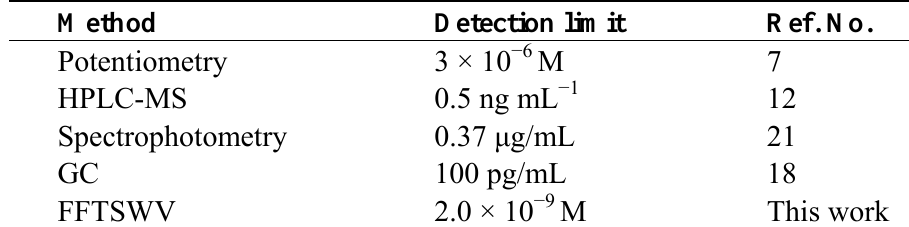
Table 2. Application of the proposed method to the determination of diclofenac in spiked humane plasma and